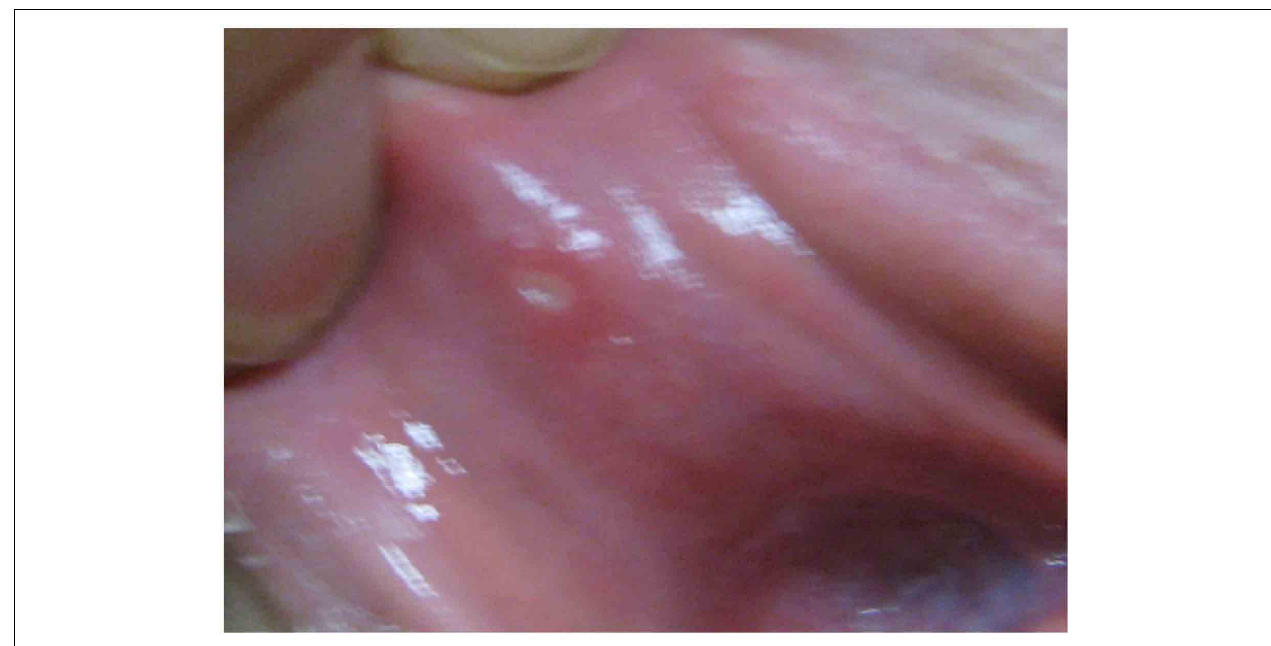
FIGURE 2 |Aphthous stomatitis of the oral mucosa. Note the erythematous ring around the yellow to gray colored ulceration in this minor aphthous stomatitis.